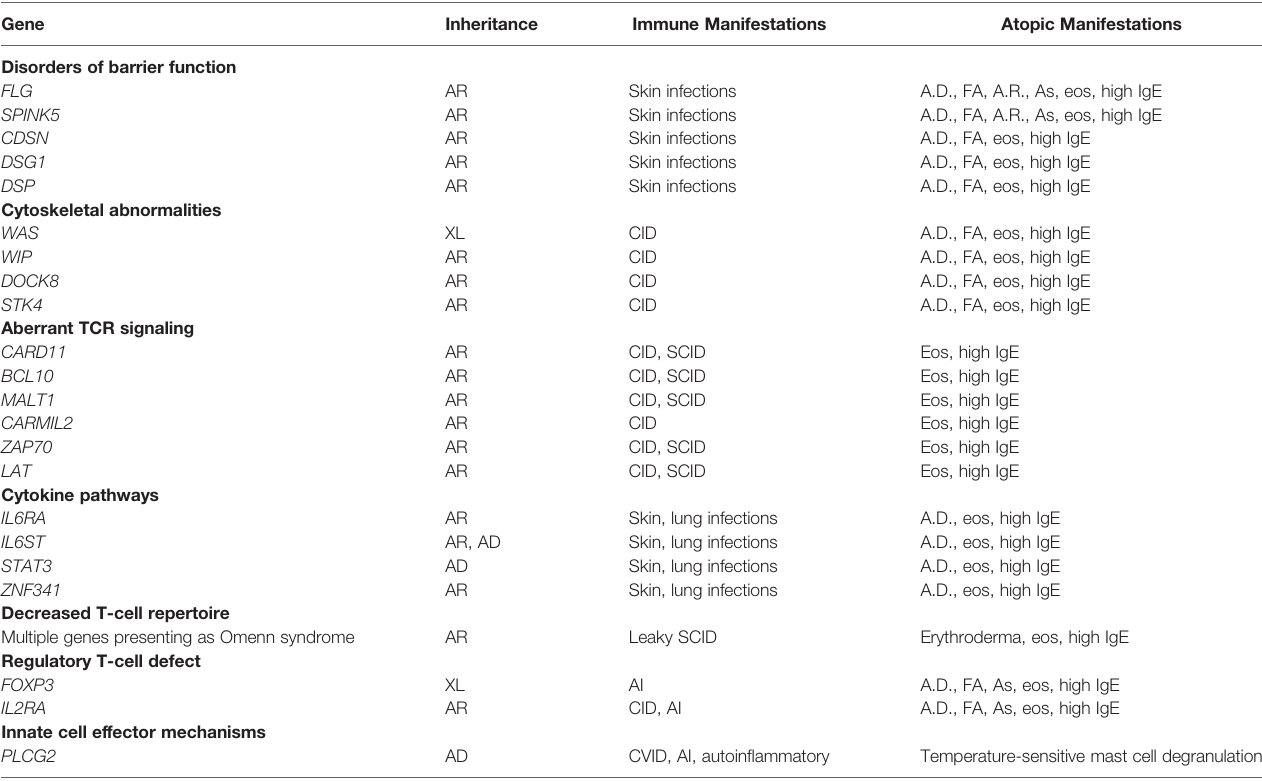
TABLE 1 | Monogenic IEI associated with atopic disease. Gene